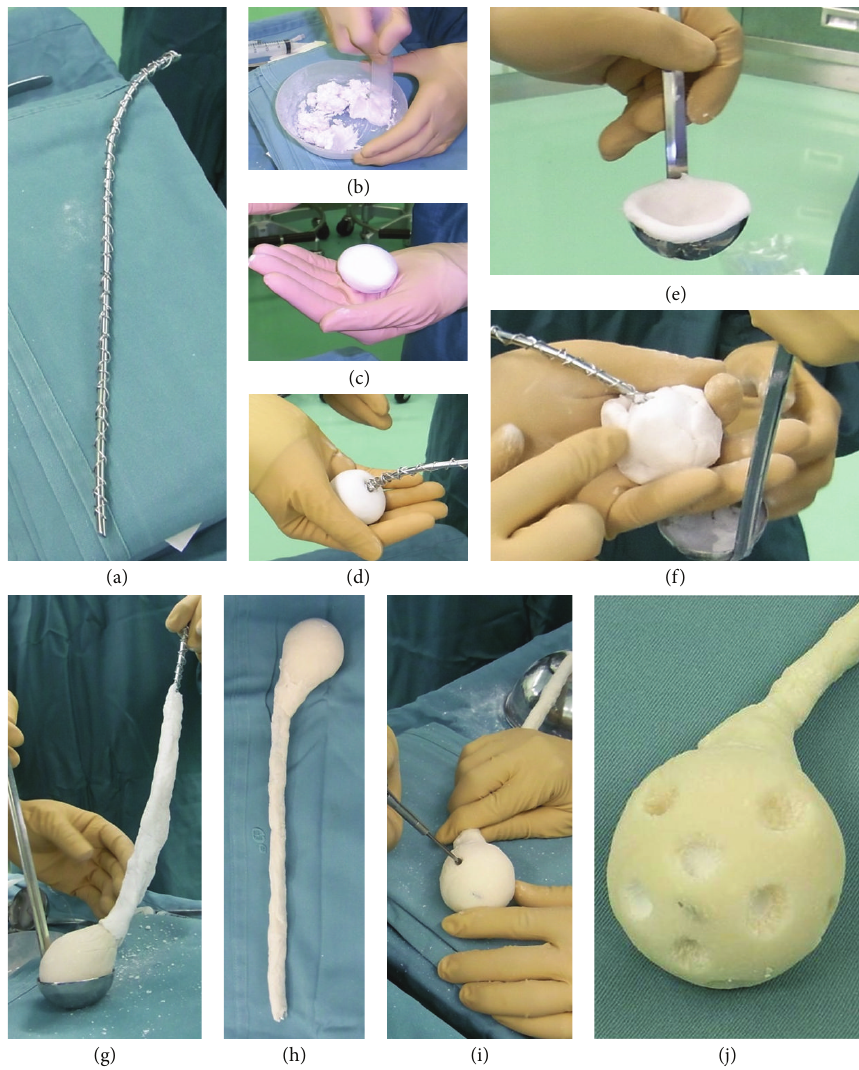
Figure 2: Steps in the making of the new type of handmade antibiotic-impregnated